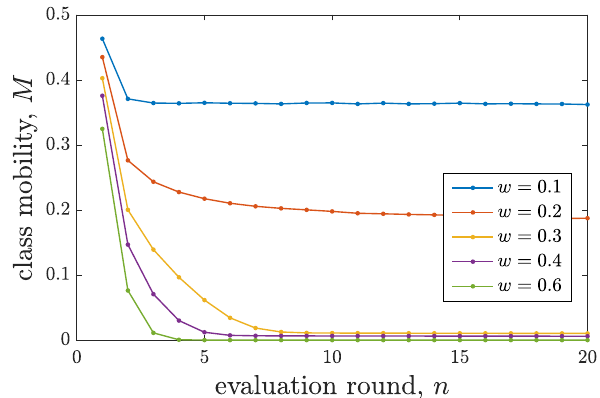
Figure 5: The class mobility M as a function of time for Case II, plotted for differ- ent values of the standard error w of the exam. When w < w quires a reasonably large value in the steady state. When w > w prestige class collapses, and M falls abruptly to a very small steady-state value. At (cid:112) w > 1 / 3 ≈ 0.577 the prior collapses for the non-prestige class as well, and M →